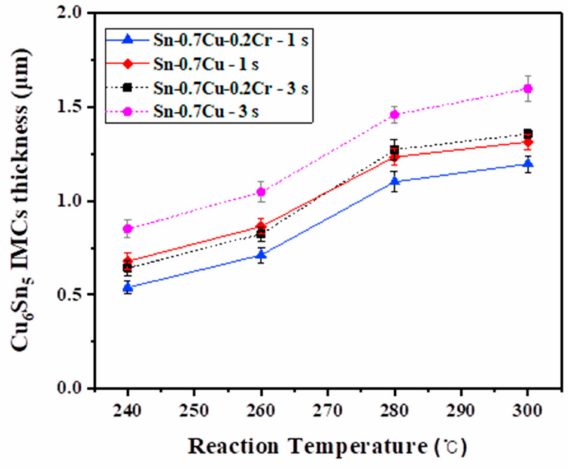
Figure 6. Thickness of the Cu 6 Sn 5 IMCs at various reaction